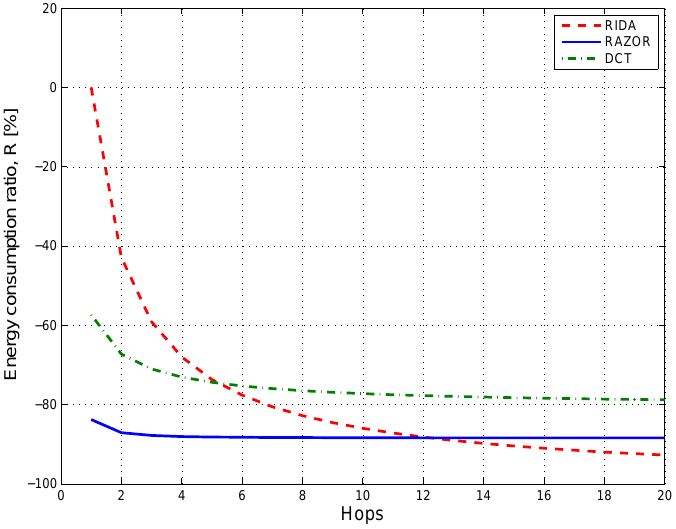
Figure 10. Performance comparison of three data compression solutions: RAZOR (blue solid line), DCT (green dash-dotted line) and RIDA (red dashed line). The three algorithms are compared in terms of the energy consumption ratio, R , varying the number of hops of the